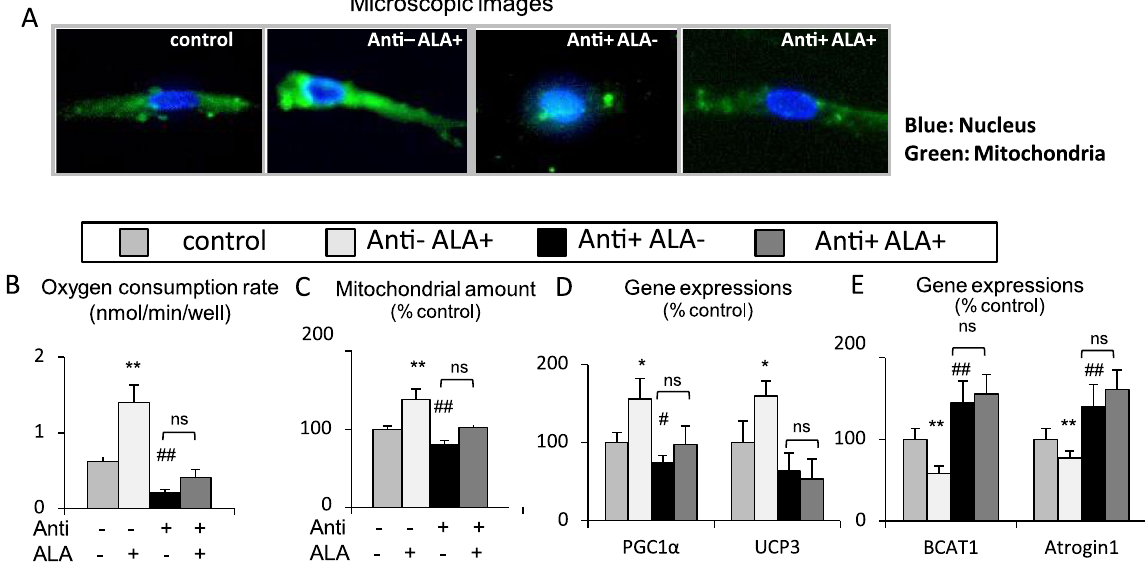
Figure 4. Promotion of mitochondrial electron transport by 5-aminolevulinic acid affects the expression of genes regulating mitochondrial activity and muscle mass in cultured myocytes. ( A ) Microscopic images of C2C12 cells (blue; nucleus, green; mitochondria), ( B ) Oxygen consumption rate (OCR), ( C ) Mitochondrial amount, ( D ) Expressions of mitochondria-related genes estimated by quantitative PCR analysis (PGC1 α , UCP3), ( E ) Gene expressions of BCAT1 and the Atrogin1 estimated by quantitative PCR analysis. N = 5 independent experiments. * P < 0.05, ** P < 0.01 versus ALA plus antimycin A. # P < 0.05. ## P < 0.01 versus control group. ns: not significant between antimycin A versus ALA plus antimycin A. ALA, 5-aminolevlinic acid; PGC1 α , peroxisome proliferator-activated receptor- γ coactivator 1 α ; UCP3, uncoupling protein-3; BCAT, branched-chain amino acid